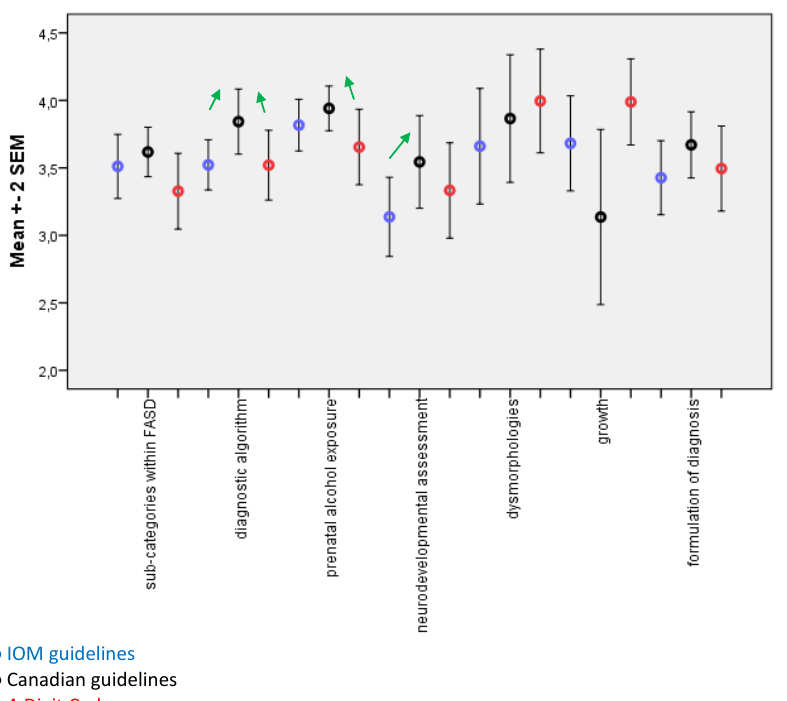
Figure 2. The overall assessment means scores and standard errors of IOM (blue), 4-Digit Code (red), and Canadian (black) guidelines to diagnose FASD (statistically significant differences are indicated by the green arrows).